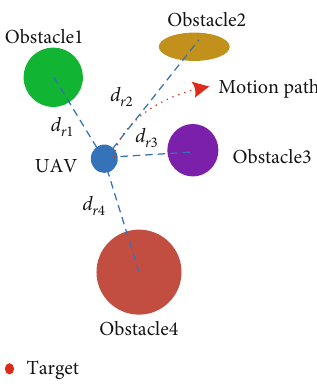
Figure 5: UAV moves around the nearest